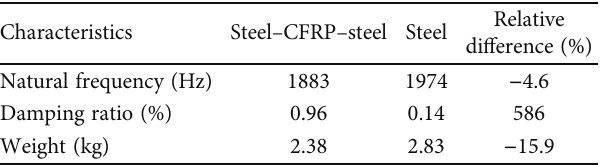
Table 5: Dynamic characteristics of the HSTs from the modal analysis